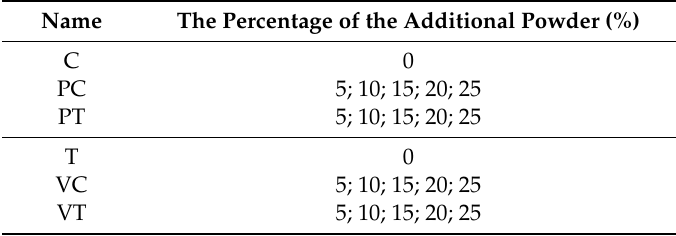
Table 1. The notation definition of the specimen with various additional amounts of